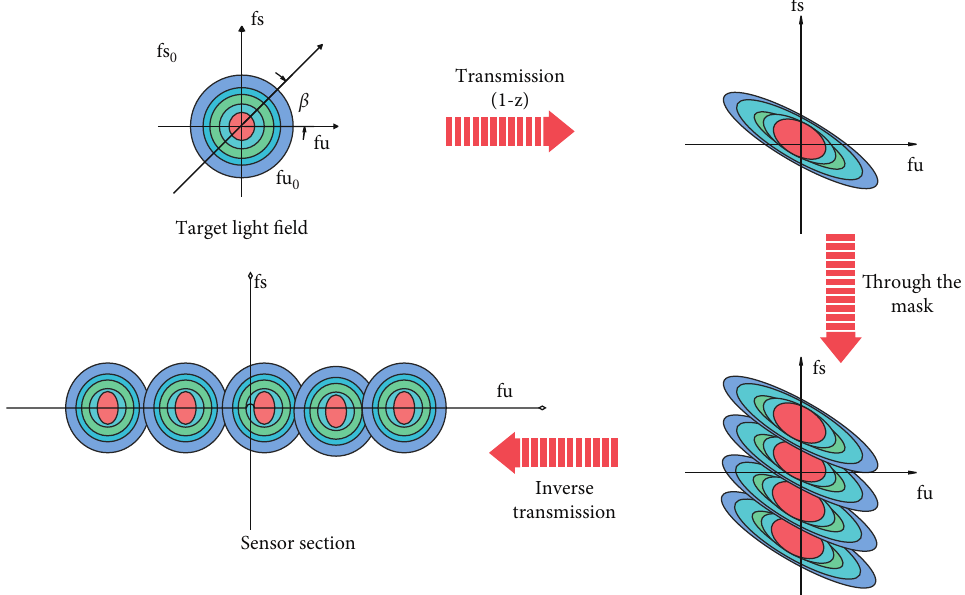
Figure 2: Changes in the light field spectrum during the compressed light field camera